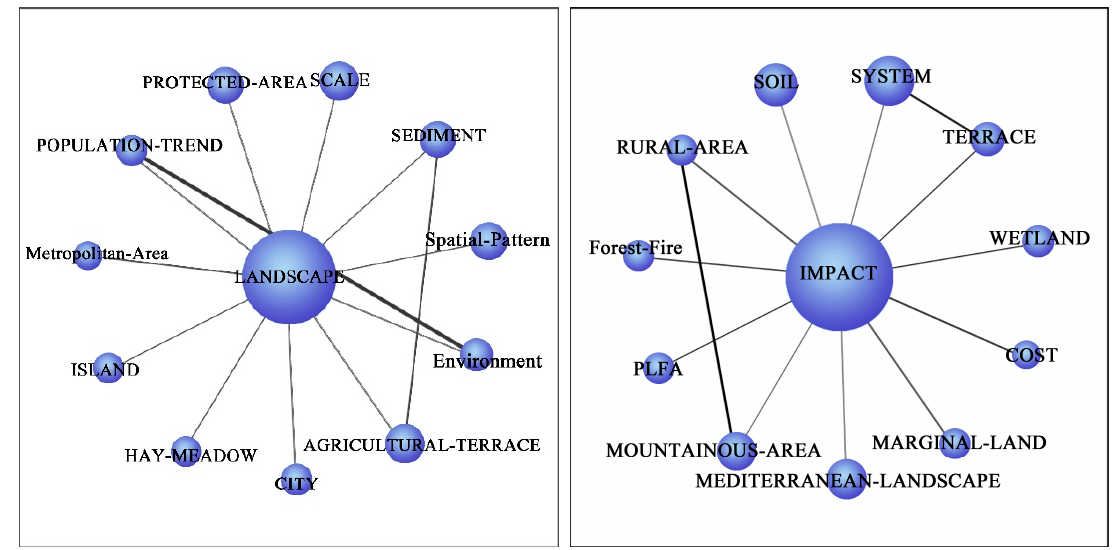
Figure 11. Landscape and impact-cluster network map.